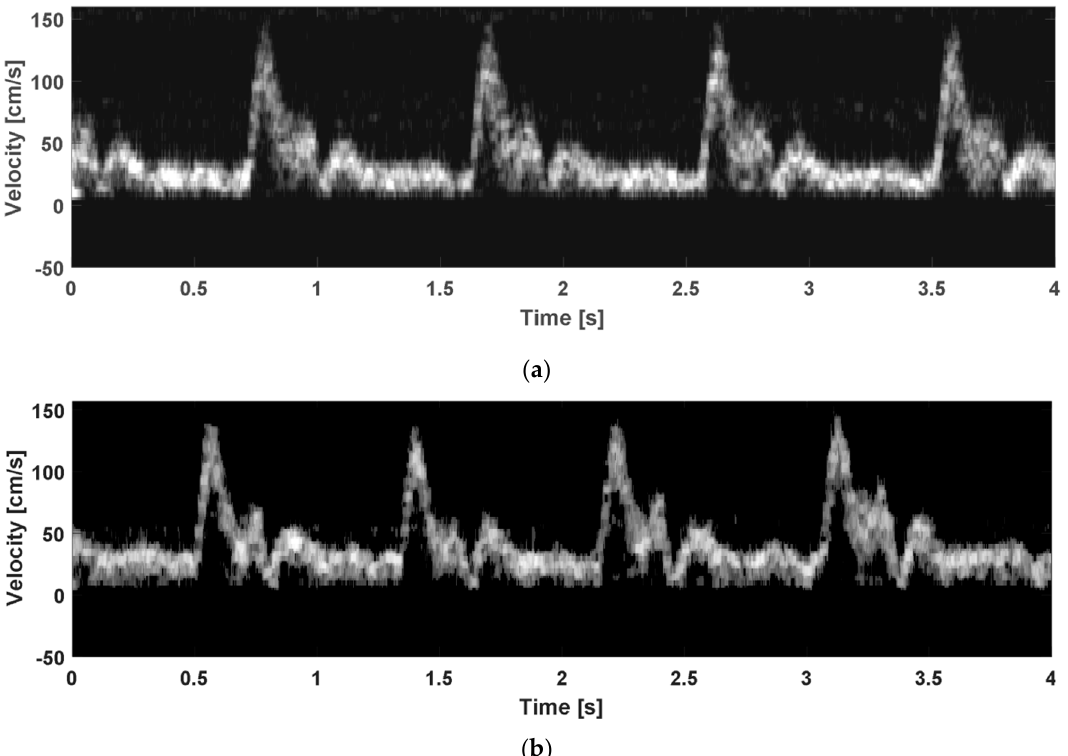
Figure 9. Spectrograms of ( a ) the left common carotid artery and ( b ) the right common carotid artery from a volunteer using the wireless carotid wearable ultrasound Doppler system prototype.